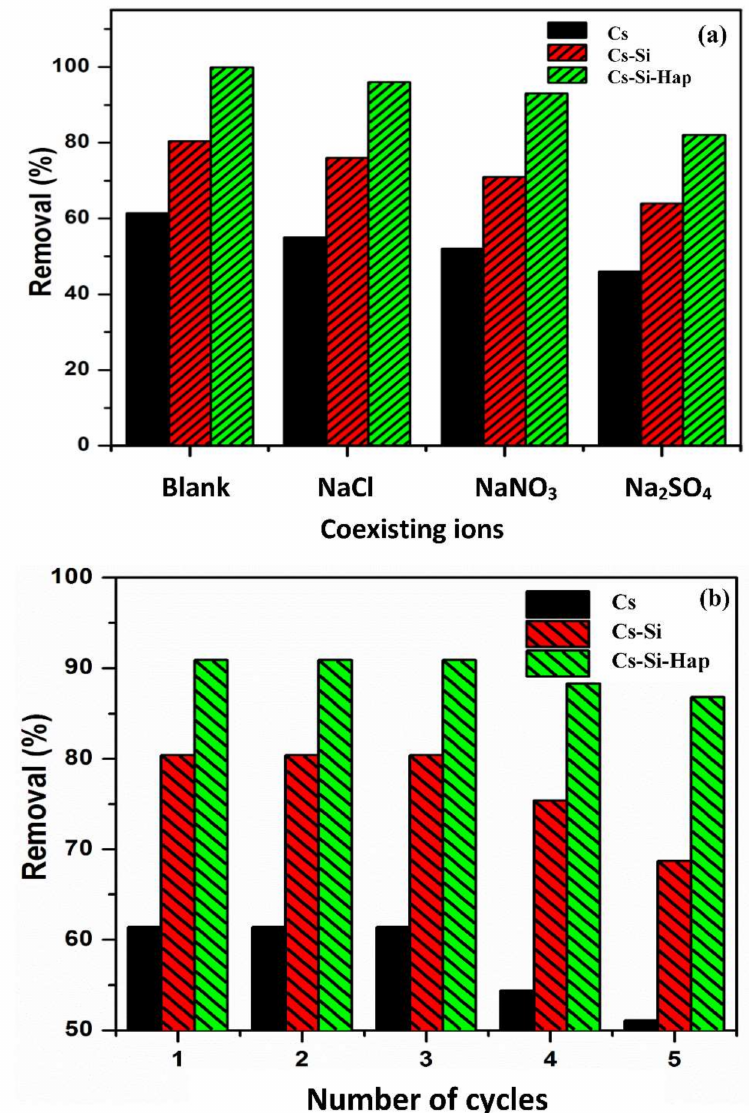
Figure 7. Effect of co-existing ions on Cr(VI) adsorption onto Cs and Cs based composites ( a ), and regeneration studies plot for Cr(VI) adsorption on Cs and Cs based composites ( b